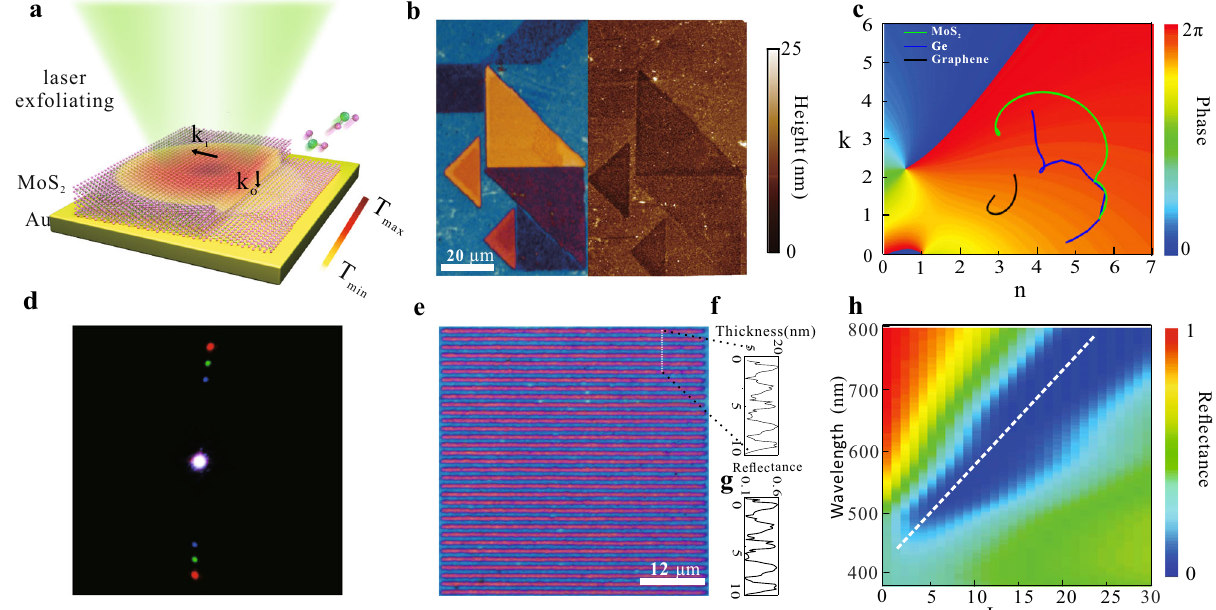
Fig. 1 Ultra-sensitive resonance manipulation by laser exfoliating MoS 2 thin fi lms. a Schematic diagram of tightly focused laser beams for exfoliating multilayer MoS 2 integrated on the Au substrate with atomic thickness precisions. b Optical and the AFM images of a Tangram pattern printed by the facile laser writing method. c The calculated total interfacial phase shifts for a dielectric layer-Au con fi guration with variant complex refractive index overlaid with the complex refractive index diagram of MoS 2 (green), graphene (black), and Ge (blue). d The calculated re fl ectance spectra of the MoS 2 thin fi lms on the Au substrate with different numbers of layers. e Microscopic image of the grating structure fabricated with a period of 1800 nm. f Surface corrugation curve of patterned nanometric gratings corresponding to the dotted line. g Re fl ectance amplitude modulations by such grating structures. h Diffraction image retrieved by using three beams at wavelengths of 450, 550, and 650 nm